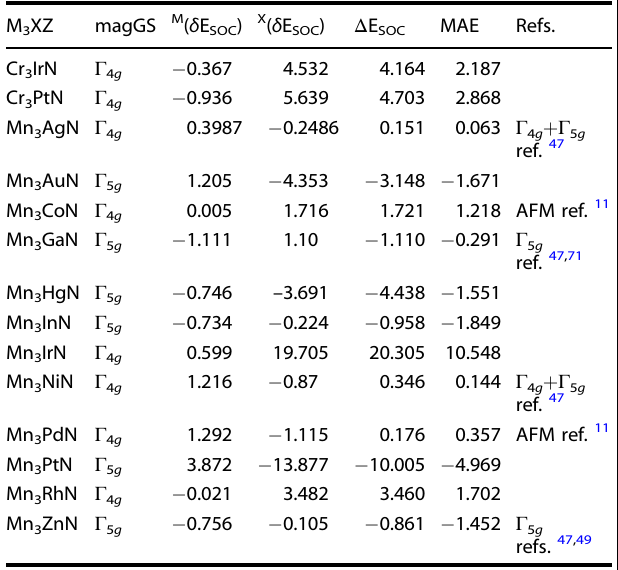
Fig. 2 Magnetic con fi gurations. Possible magnetic structures of antiperovskites: a Γ 5 g , b Γ 4 g , c FM, d PM, e cAFM-1, f cAFM-2, g cAFM-3, and h M-1. The spin chirality for Γ 4 g and Γ 5 g is assumed to be + 1. Table 1. Compilation of the APVs (M 3 XZ) with noncollinear magnetic ground